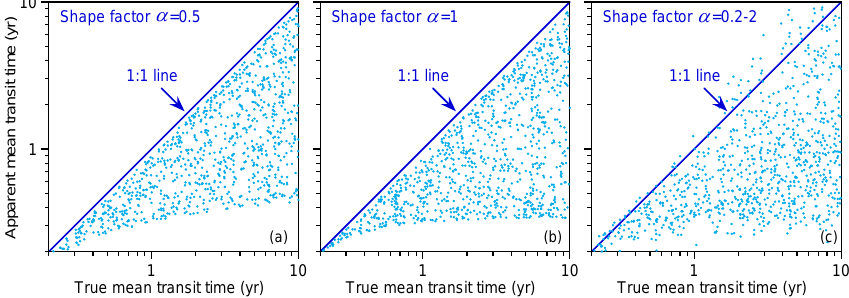
Figure 7. Apparent MTT inferred from seasonal tracer cycles, showing order-of-magnitude deviations from true MTT for 1000 synthetic catchments. Each synthetic catchment comprises two subcatchments with individual MTTs randomly chosen from a uniform distribution of logarithms spanning the interval between 0.1 and 20 years, with each pair differing by at least a factor of 2. In (a) and (b) , both subcatchments have shape factors α of 0.5 and 1, respectively; in (c) , the subcatchments’ shape factors are independently chosen from the range of 0.2–2. Apparent MTTs were inferred from the amplitude ratio A S /A P of the combined runoff using Eq. (10), with an assumed value of α = 0.5 for (a) , α = 1 for (b) , and also α = 1 for (c) , both because α = 1 is close to the average of the randomized α values and because α = 1 is typically assumed whenever Eq. (10) is applied to real catchment data.